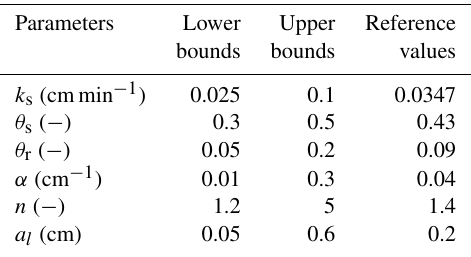
Table 1. Prior lower and upper bounds of the uncertainty parameters and reference